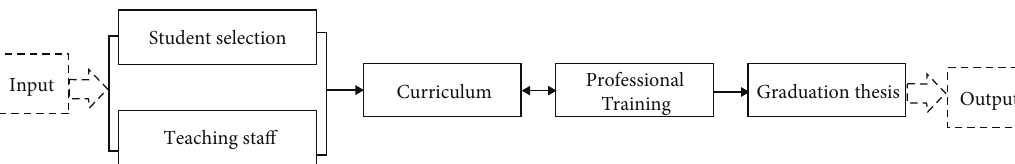
Figure 8: Cultivation process subelement relationships.